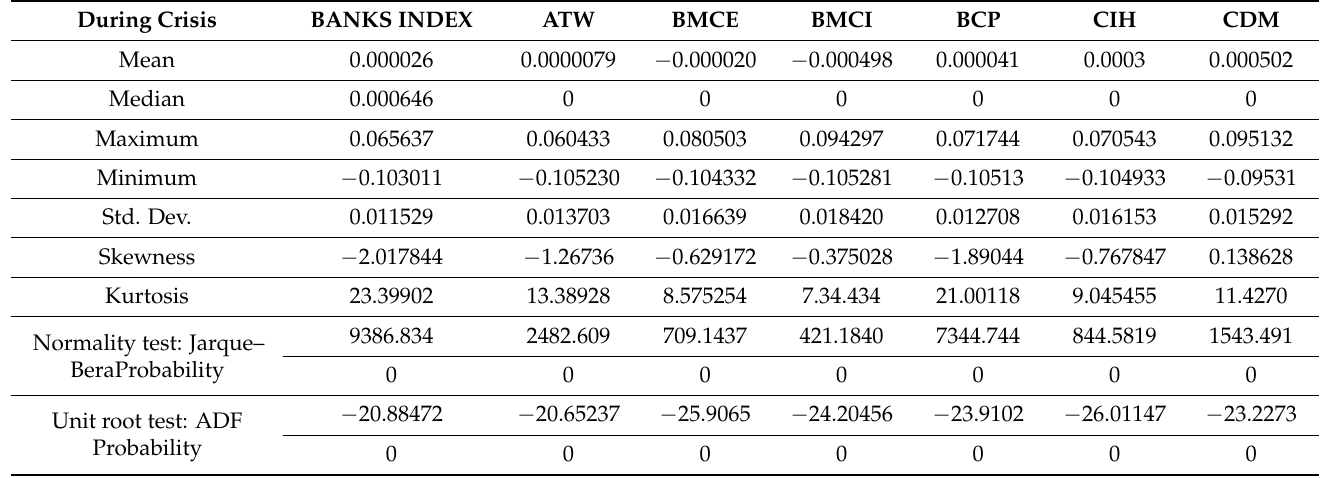
Table 3. Descriptive statistics and stationarity results (during COVID-19